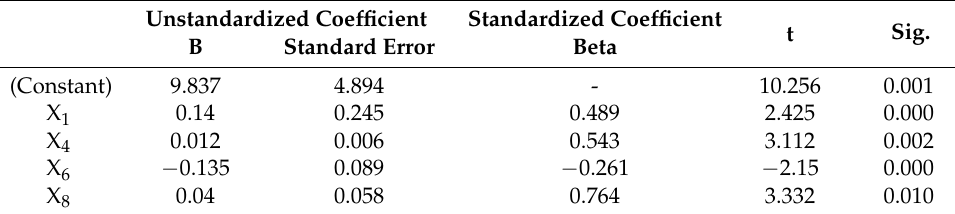
Table A2. Coefficient of regression model b